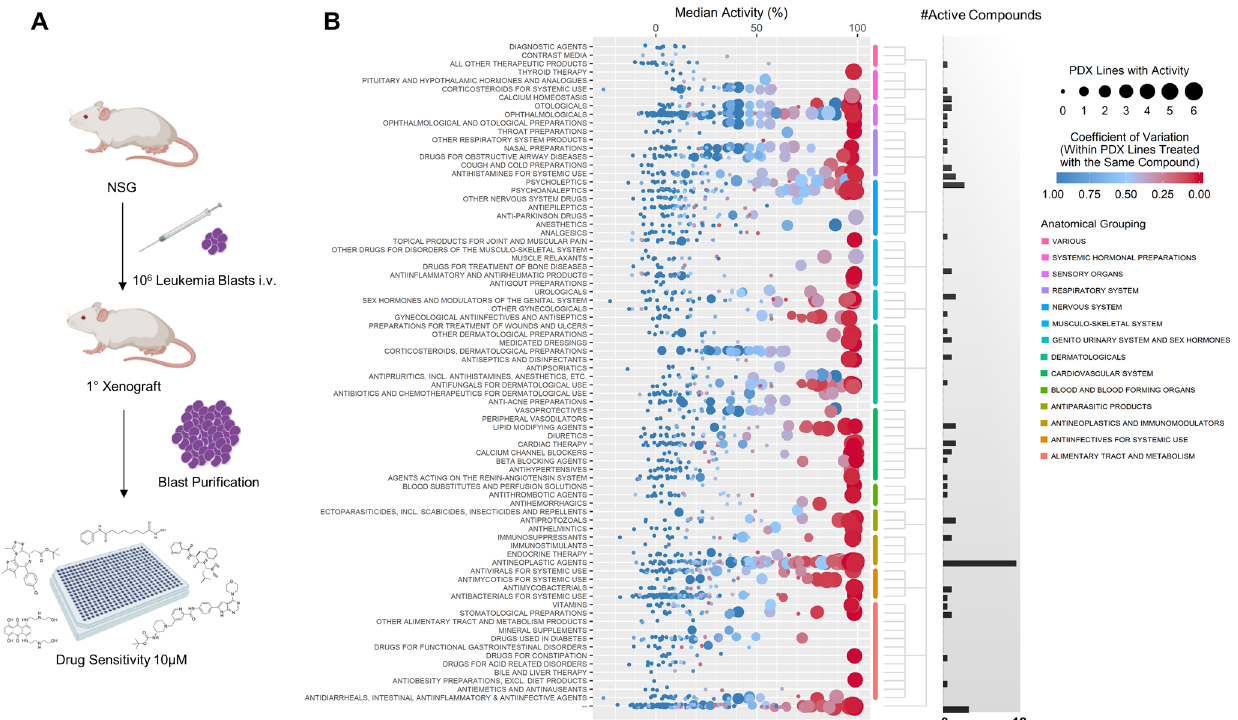
Fig. 1 | High throughput screening of infant ALL. A Study design. Primary leu- kemia blasts were thawed and injected into immunode fi cient mice. Cells were harvested from moribund mice as described in “ Methods ” and viably stored in liquid nitrogen. Samples were thawed for drug sensitivity studies at a later time point. Figure created with BioRender.com, academic license. B In vitro activity of FDA-approved compounds. Six passaged patient specimens were thawed and cultured in the presence of compounds at a single concentration of 10 µ M in duplicate as described in “ Methods ” . Normalized activity, de fi ned as percent